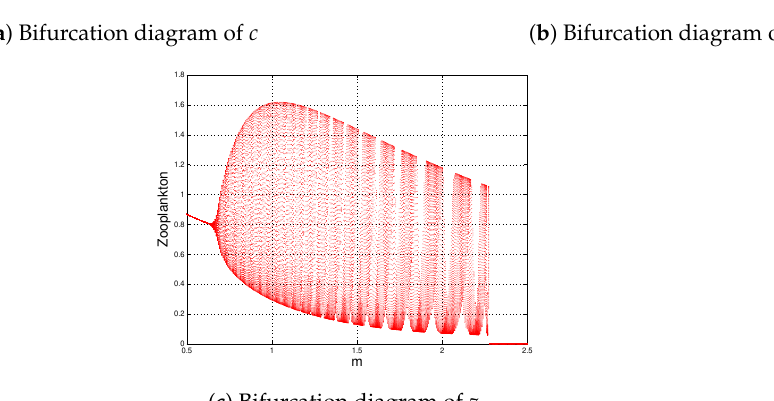
Figure 14. Bifurcation diagrams of system (1) taking m as the bifurcation parameter, while the others remain unchanged, as in Figure 6. Here, (cid:98) E ( (cid:98) c , (cid:98) p , (cid:98) z ) is stable when m ∈ ( 0.0, m [ H ] = 0.6533 ) and unstable with a periodic solution when m ∈ ( 0.6533,2.287 ) . When m > m [ tc ] = 2.287, trivial equilibrium E 0 = ( 0,0,0 ) exists corresponding to the depletion of oxygen and the extinction of